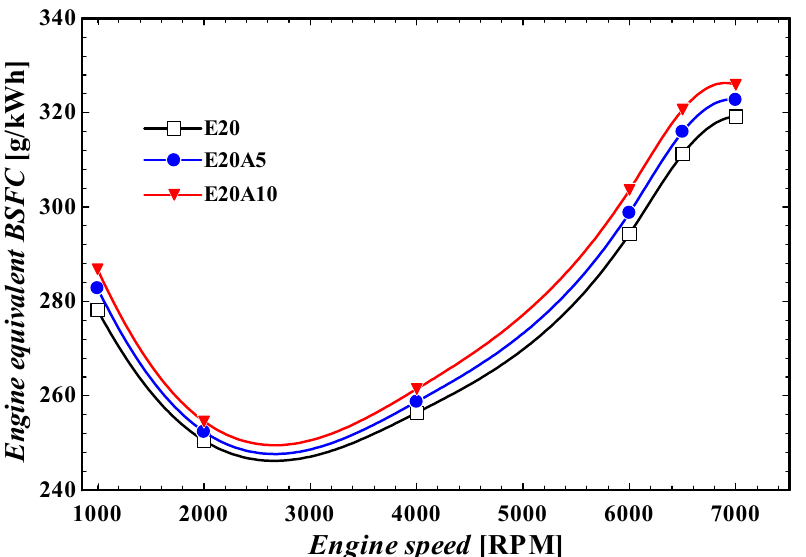
Figure 7. Engine equivalent BSFC at various engine speeds at different fractions of ammonia.